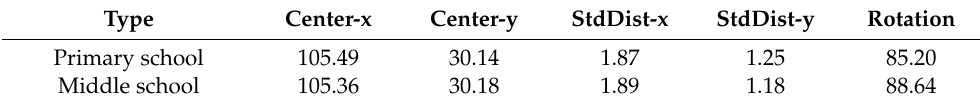
Table 1. The parameters of SDE.